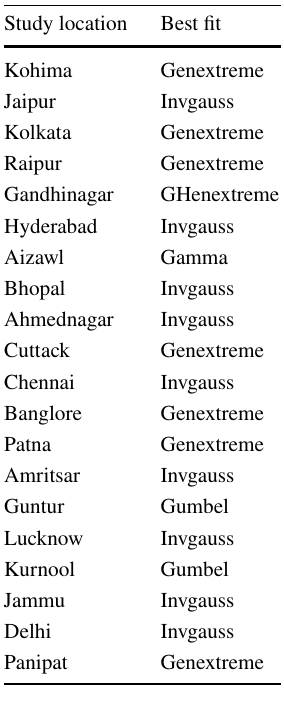
F stands for the Fisher distribution, t stands for Student’s t -distribu- tion and GEV stands for generalized extreme value